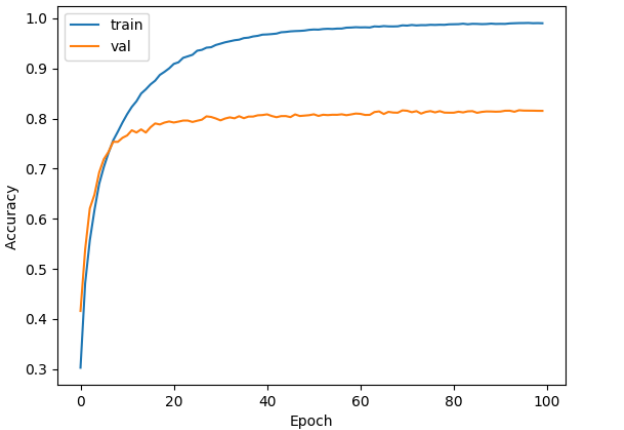
Figure 13. The accuracy of DEMON and proposed CNN (80%).